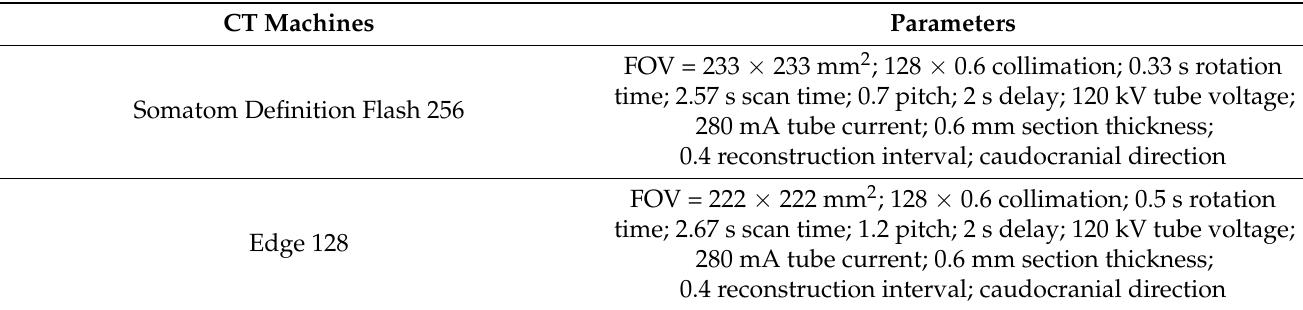
Table 1. CTA imaging